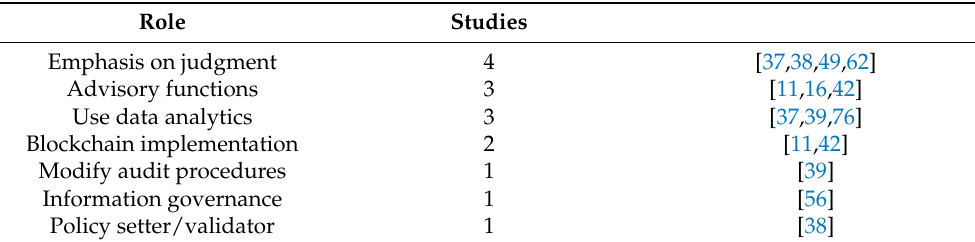
Table 4. Impacts on accountants’ role.